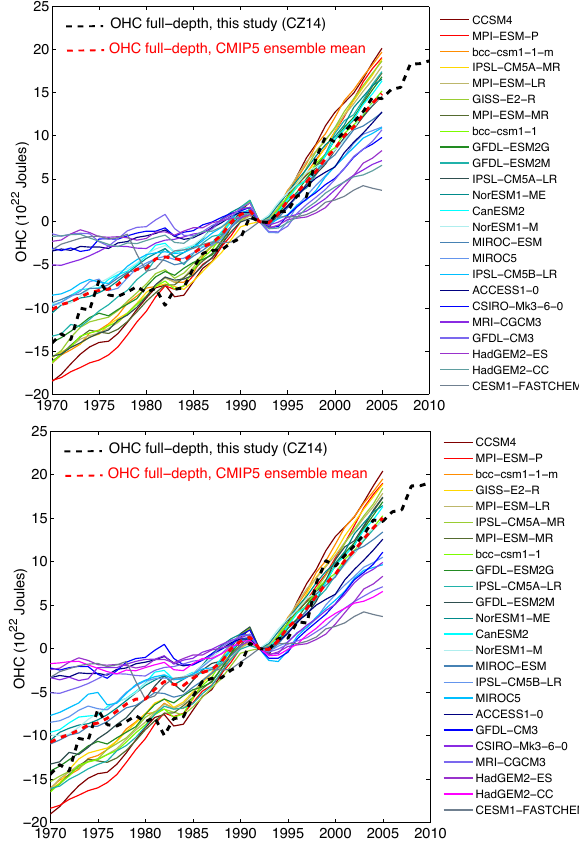
Figure 4. Full-depth OHC by individual CMIP5 models and obser- vations. The observational OHC time series (black dashed) uses the CZ14 method (0–700m), Levitus et al. (2012) (700–2000m), and Purkey and Johnson (2010) (2000m–bottom). The multimodel en- semble median is shown in dashed curve. A quadratic fit to the en- tire pre-industrial control run was used to correct the CMIP5 time series for model drift in the upper panel, and the results for the linear fit are shown at the